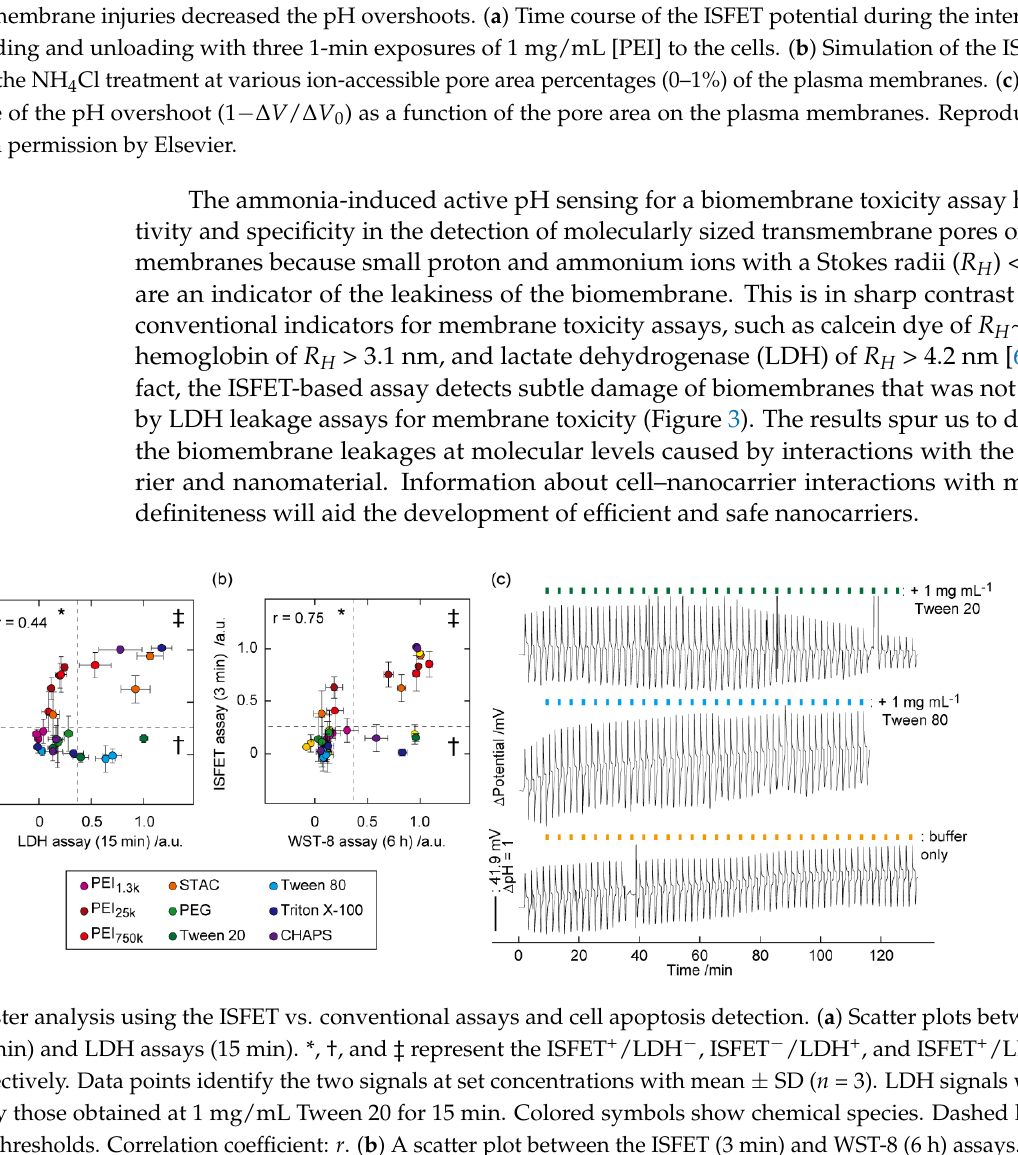
Figure 2. Biomembrane injuries decreased the pH overshoots. ( a ) Time course of the ISFET potential during the intervals of NH 4 Cl loading and unloading with three 1-min exposures of 1 mg/mL [PEI] to the cells. ( b ) Simulation of the ISFET signal during the NH 4 Cl treatment at various ion-accessible pore area percentages (0–1%) of the plasma membranes. ( c ) The reduction rate of th e pH overshoot (1−Δ V /Δ V 0 ) as a function of the pore area on the plasma membranes. Reproduced from [46] with permission by Elsevier.